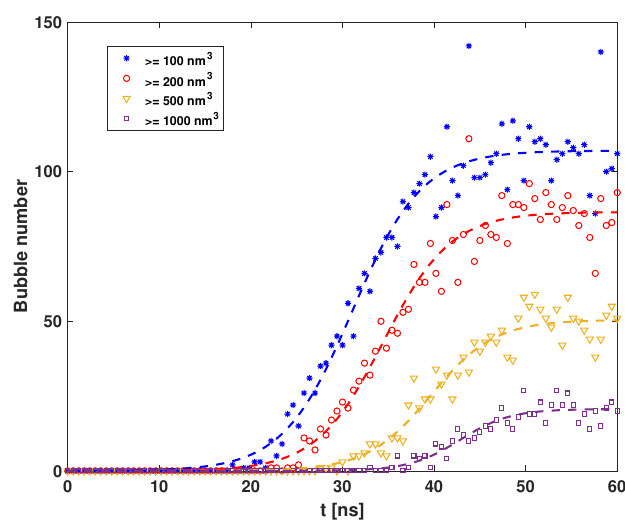
Figure 4. Time evolution of bubble number with a start-up pressure of 30 MPa. The dashed line is the fitting curve. At t = 0 ns, the system starts nucleation.